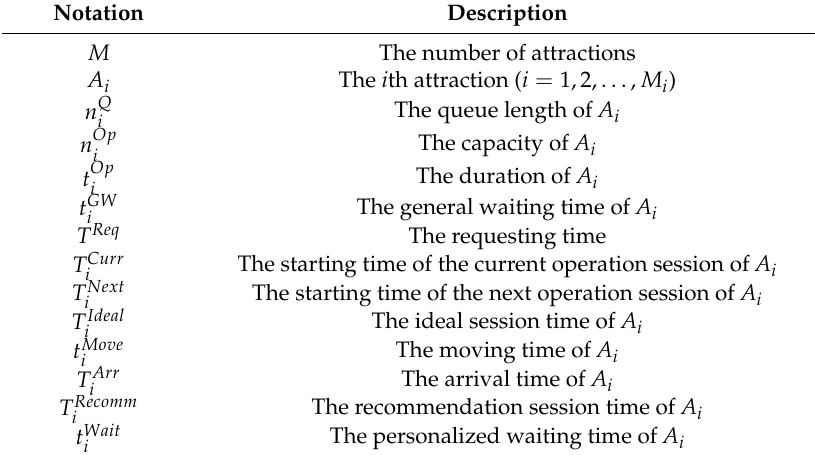
Table A1. Notations used in the